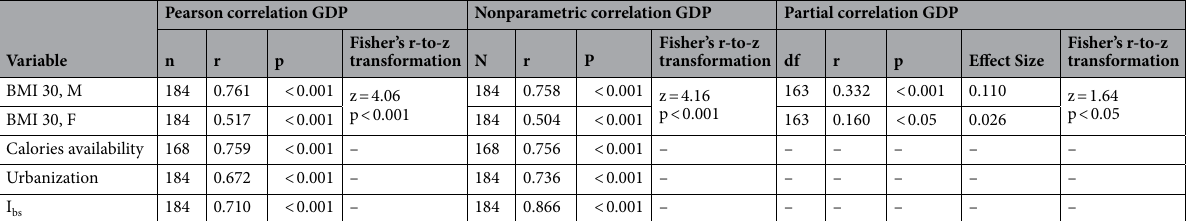
Table 2. Correlation coefficients and Fisher’s r-to-z transformations of bivariate and partial correlations between GDP per capita and female and male obesity prevalence. Bivariate and partial correlations are reported. –, Controlled variable or not relevant. Data sources: Total calories availability data from the FAO’s FAOSTAT. BMI ≥ 30 prevalence (male and female) from the WHO Global Health Observatory; GDP per capita from the World Bank; Urbanization data from WHO; I bs from the previous publications.